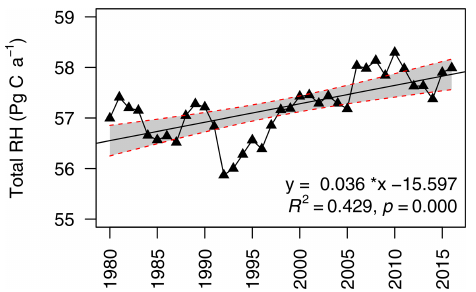
Figure 4. Interannual changes in global heterotrophic respiration (RH) from 1980 to 2016. The grey area indicates 95% confi- dence intervals. For the linear regression model, R 2 = 0 . 429 and p < 0 .